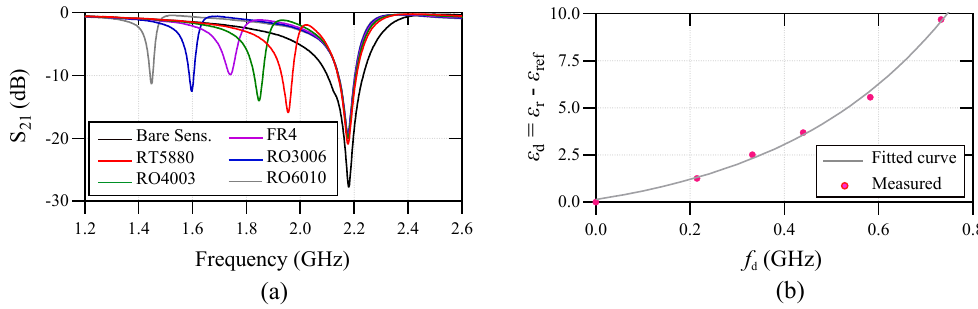
Figure 8. ( a ) The measured transmission responses of the sensor for various test dielectric samples. ( b ) The measured and curve fitted frequency splitting for various dielectric samples.